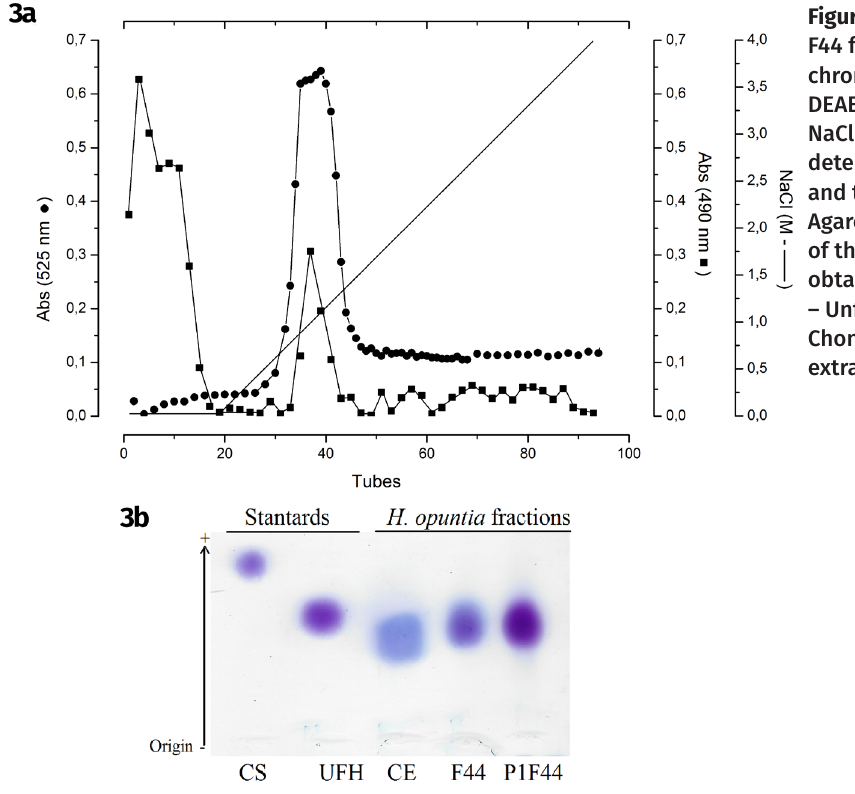
Figure 3. Purification of the F44 fraction by ion exchange chromatography employing DEAE-cellulose under a linear NaCl gradient (3a) with the detection of SP in DMB at A 525nm and total hexoses at A . 490nm Agarose gel electrophoresis (3b) of the F44 and P1F44 fractions obtained from H. opuntia .